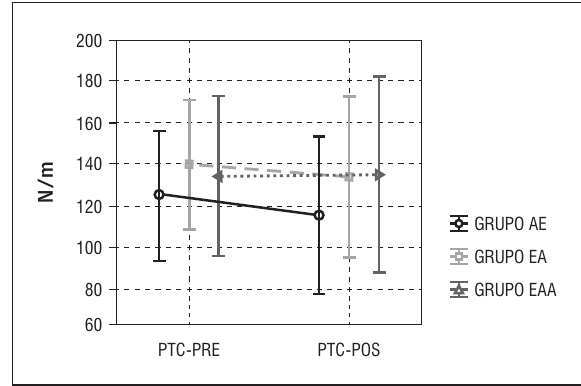
Figura 2 - Média e desvio-padrão do PTC, dado em Newton por metro (N/m), antes e depois da aplicação de alonga- mento estático (AE), do exercício aeróbico (EA) e do alongamento estático mais exercício aeróbico (EAA)